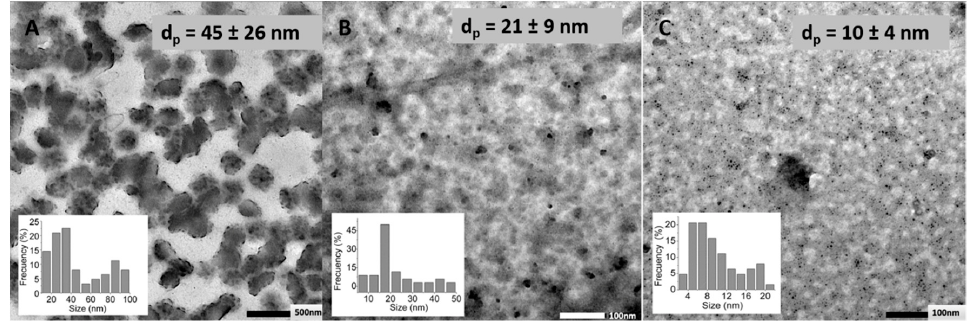
Figure 4. Transmission electron microscopy (TEM) microphotographs of ( A ) DVS, ( B ) BDDE, and ( C ) PEGBNH 2 , crosslinked (1:1, HA:crosslinker molar ratio) HA (2.1 MDA) nanoparticles, average particle sizes (d p ), and particle size distributions.